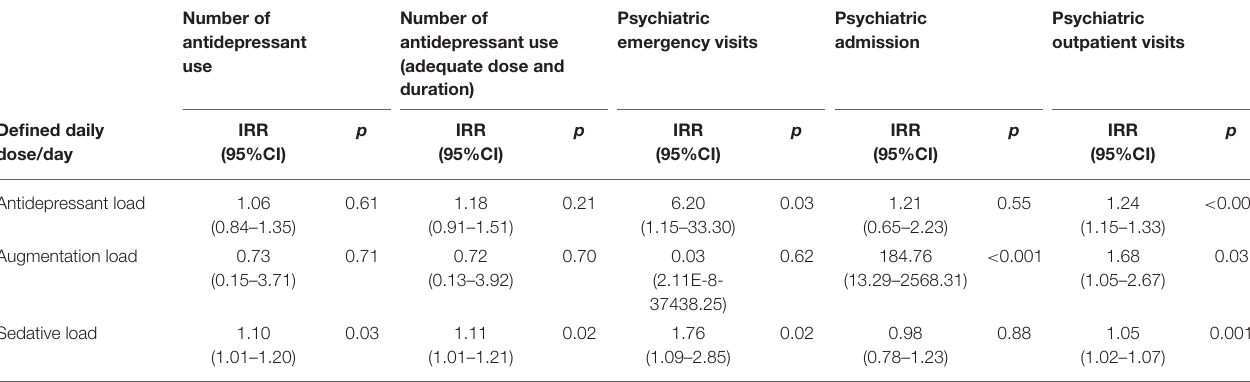
TABLE 3 | Multiple regression analyses for the relationship between categories of psychotropic dissection and clinical features within 2-year of disease onset*. Number of